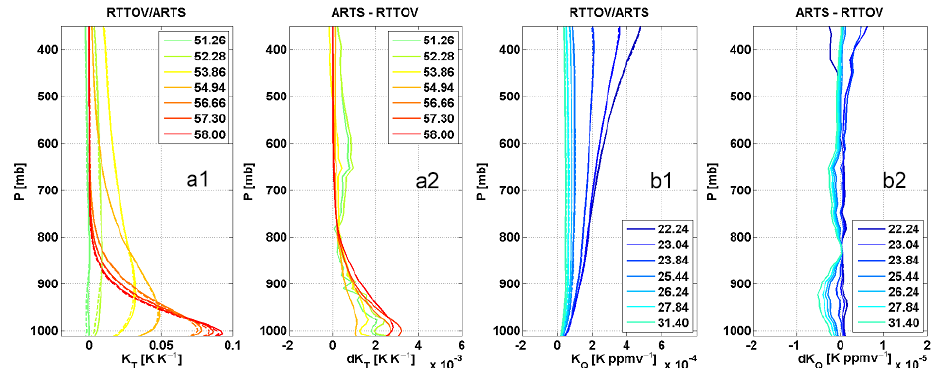
Figure 9. As in Fig. 7, but for Jacobians calculated with ARTS (solid line) and the RTTOV-gb K-module (dashed line). Panels (a2, b2) show Jacobian differences between ARTS and RTTOV-gb K-module, for temperature and absolute humidity respectively.